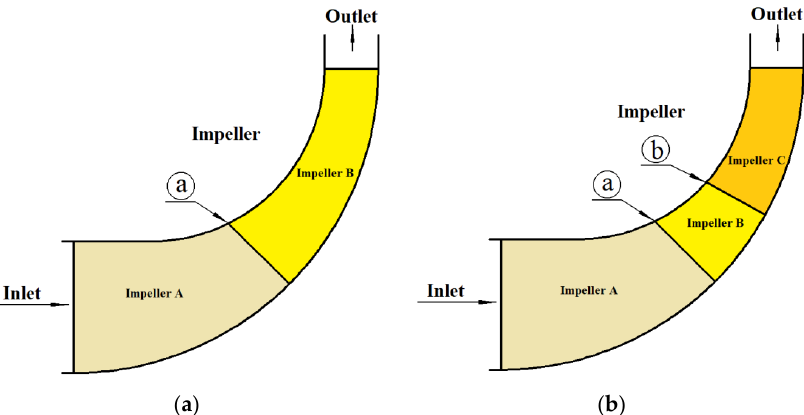
Figure 3. Decomposition of the impeller with splitter blades: ( a ) Impeller with one row of splitter blades; ( b ) Impeller with two rows of splitter blades.